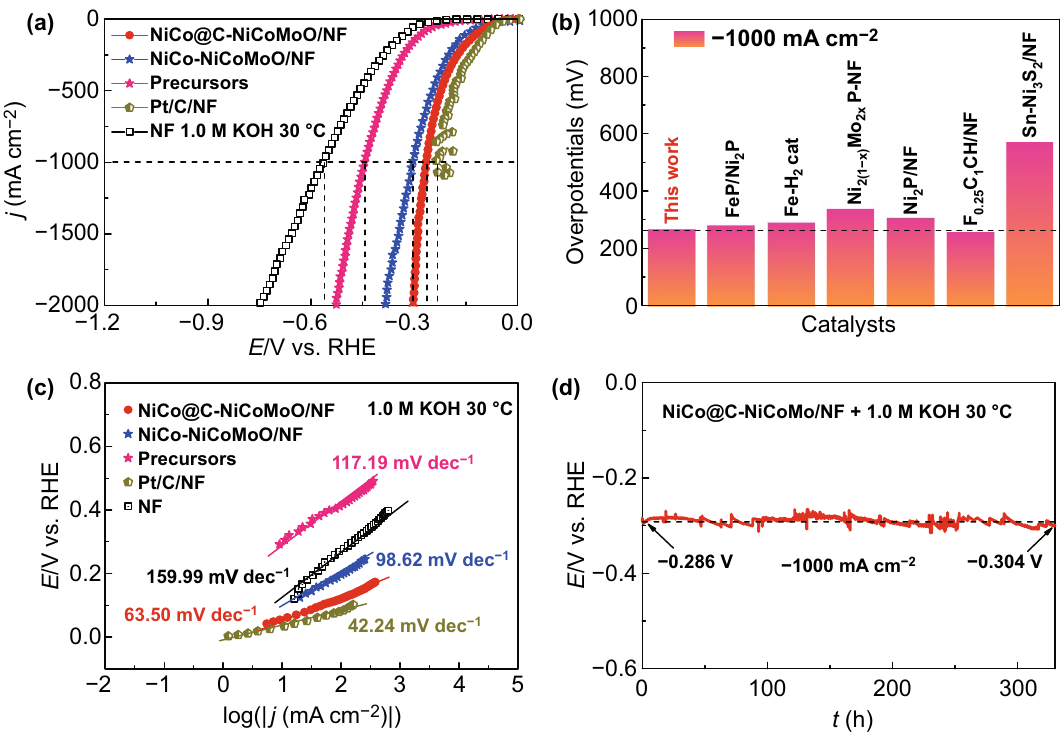
Fig. 4 a LSV curves of HER for investigated samples. b Comparisons of HER overpotentials in this work and reported catalysts [31, 47–52]. c Corresponding Tafel curves. d CP